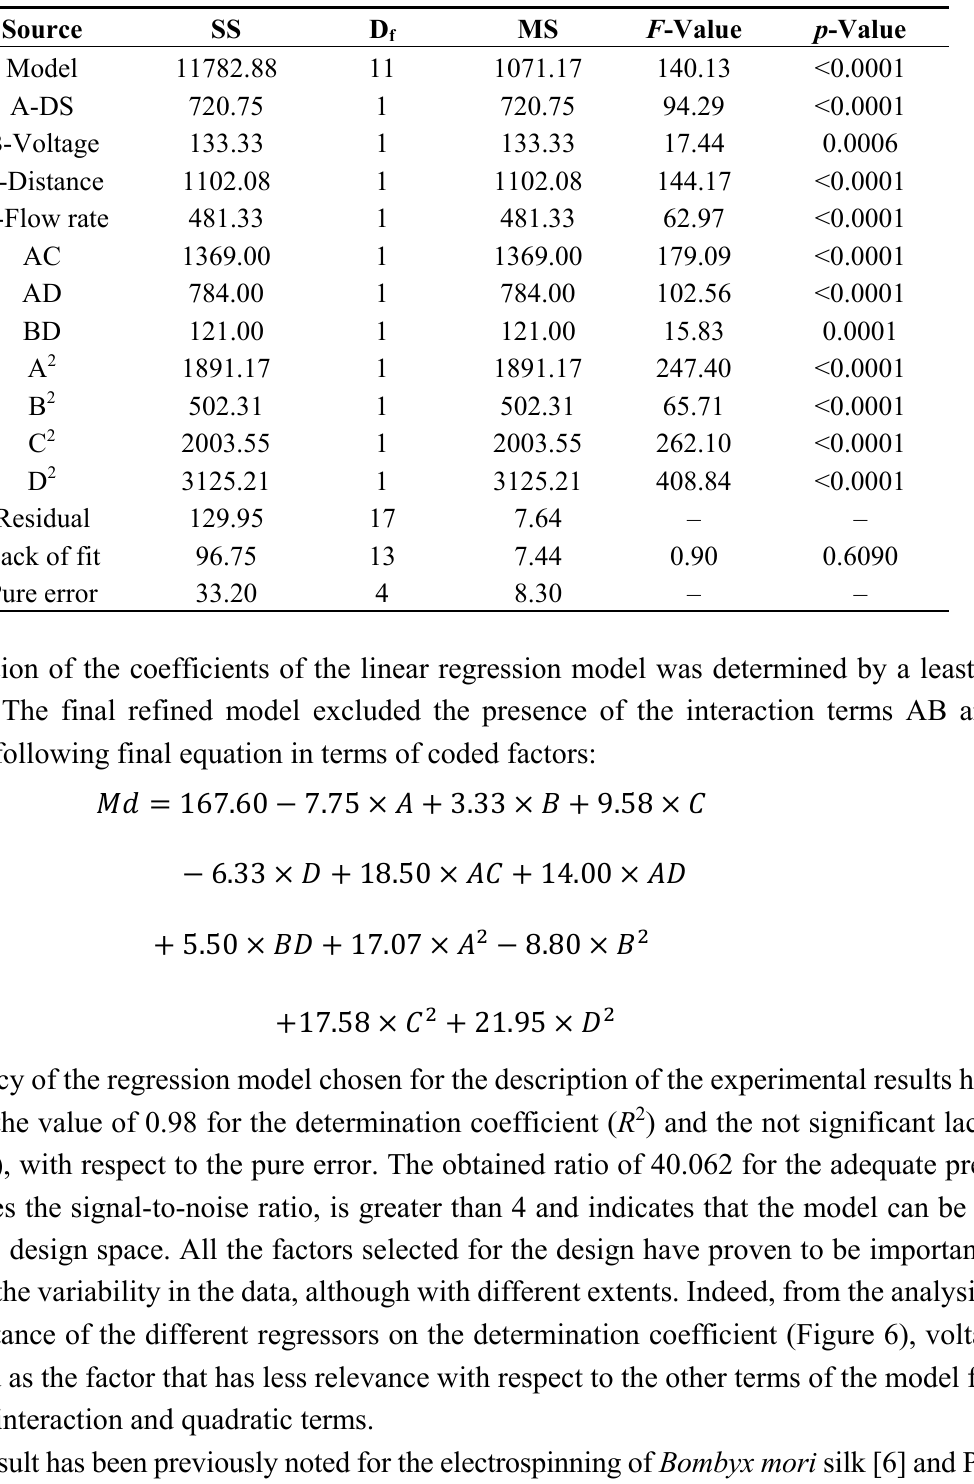
Table 6. ANOVA for response surface reduced quadratic model of the mean fibers diameter (SS = sum of squares, D f = degrees of freedom, MS = Mean